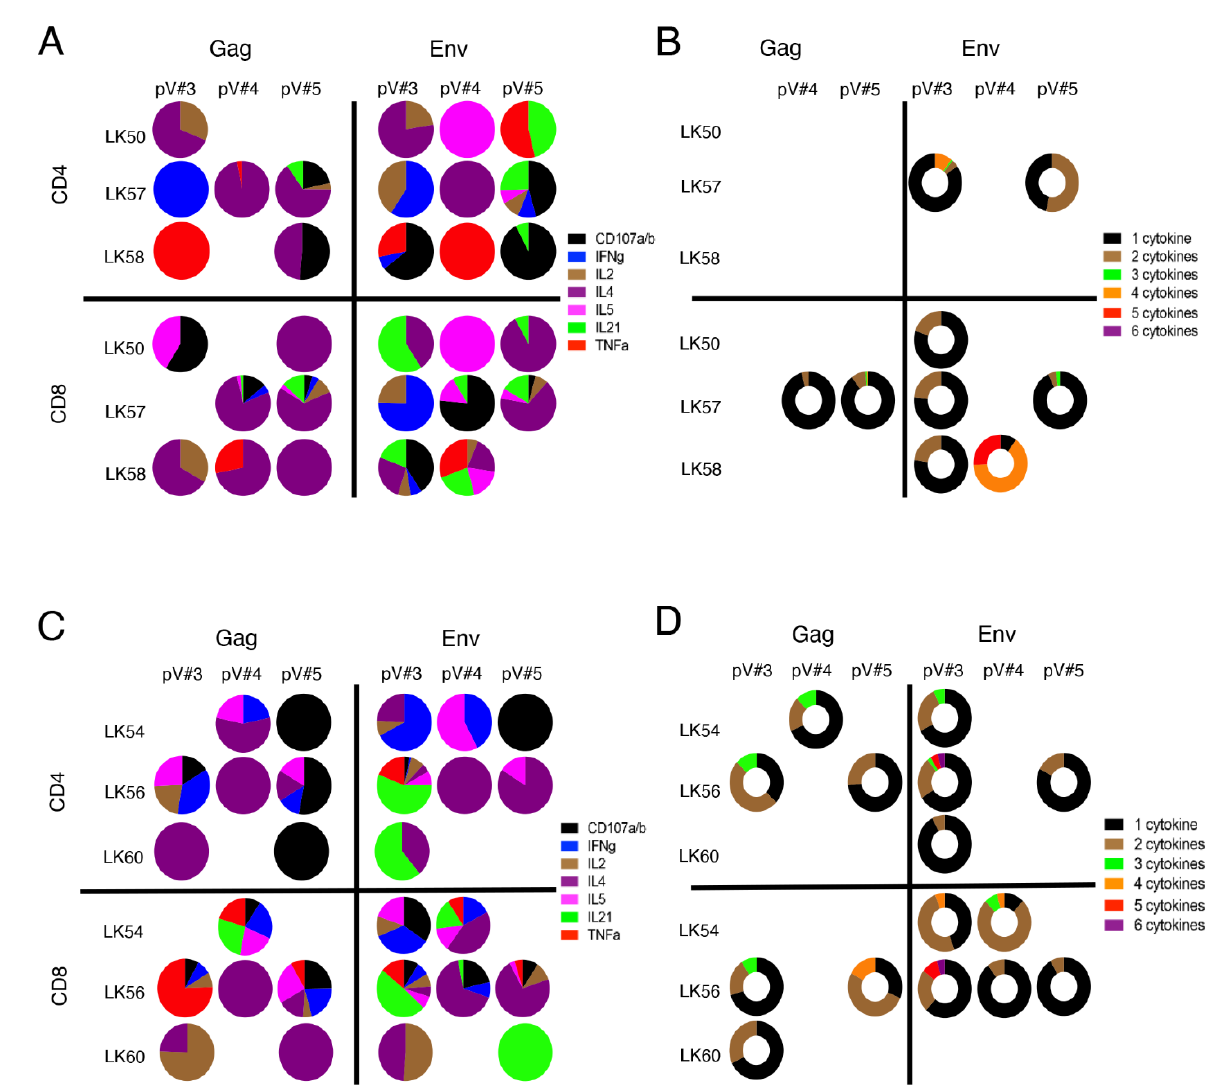
Figure 7. Polyfunctional CD4+ and CD8+ T cell response to vaccine antigens in vaccinated protected (VP) and vaccine infected (VI) macaques. Peripheral LNs were isolated at the two weeks post vaccination (pV) time points, including pV#3, pV#4, and pV#5, and were stimulated with overlapping Gag and Env peptide pools. Following stimulation, cells were stained for the presence of CD107a/b, IFN γ , IL2, IL4, IL21, and TNF α . Each segment of the pie represents the proportion of different cytokines produced by either CD4 or CD8 T cells in presence of SIV antigens in VP ( A ) and VI ( C ) macaques. Each segment of the donut represents the proportion of CD4+ or CD8+ T cells secreting the combination of multiple cytokines in VP ( B ) and VI ( D ) macaques.